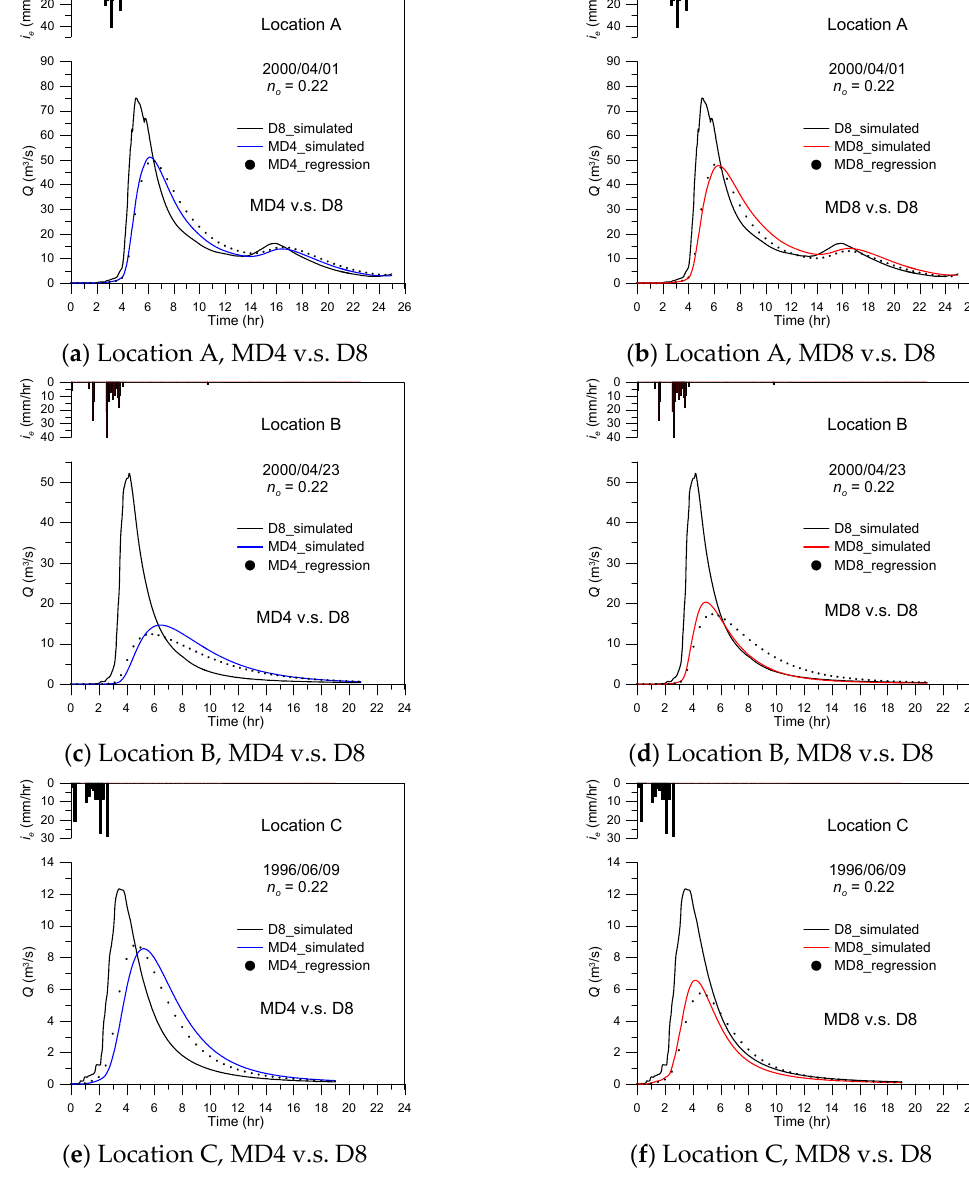
Figure 13. Comparisons of discharge hydrographs generated from the distributed runoff model and the regression model at three designated outlets.